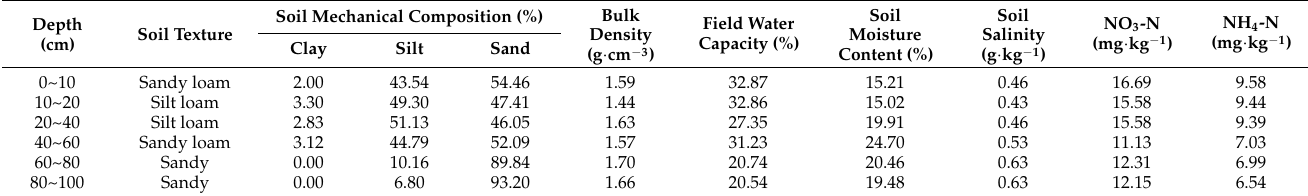
Table 1. Soil physical and chemical properties at the experimental site.